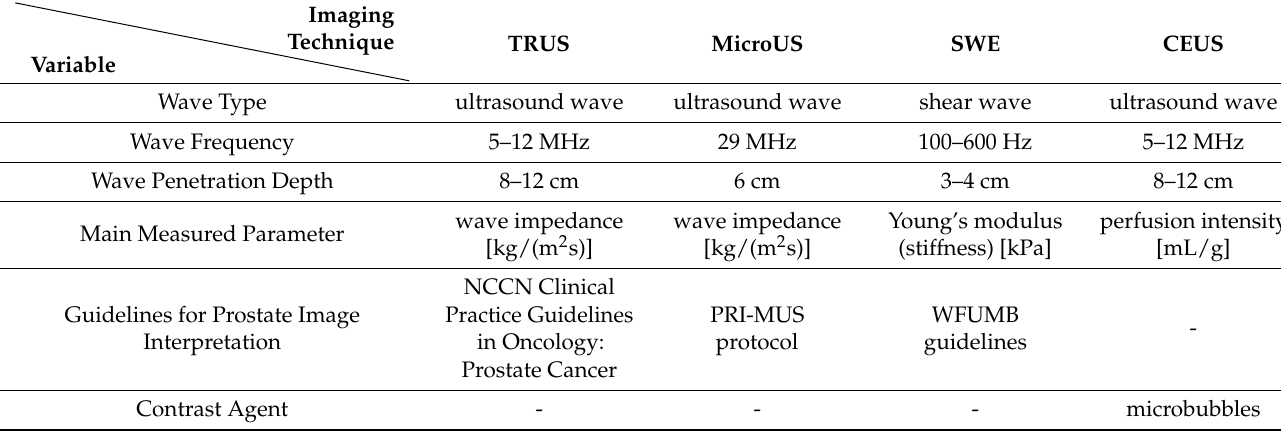
Table 5. Main technical characteristics of the ultrasound